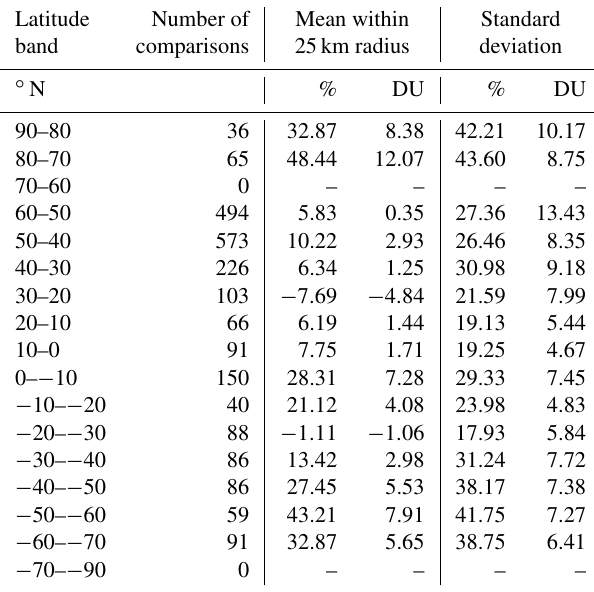
Table 2. Mean difference and standard deviation per 10 ◦ latitude band for the same data as displayed in Fig. 10, with the median deviation also